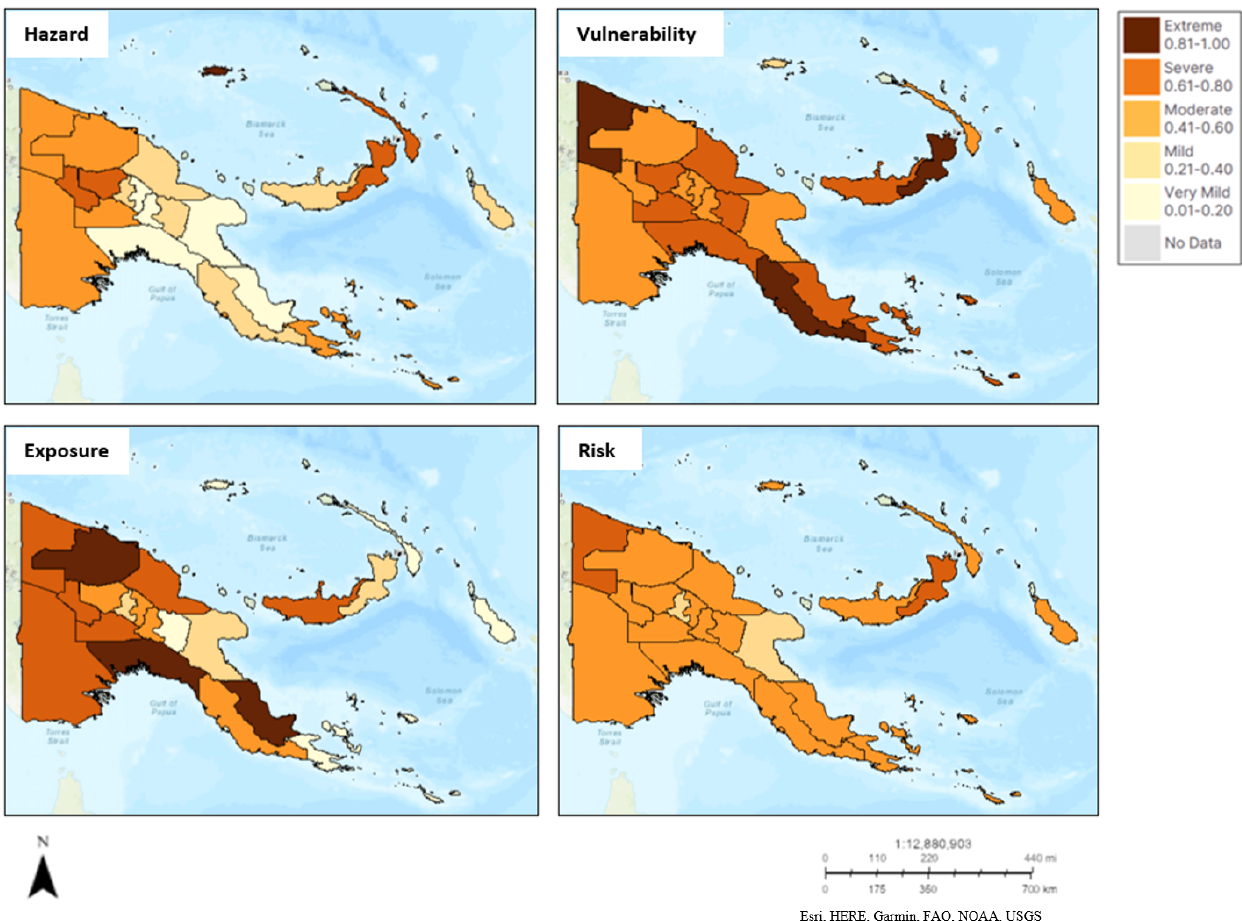
Figure 9. Overall drought risk maps of PNG provinces for 2020 including a drought hazard, drought vulnerability, drought exposure, and drought risk map detailing the index level of each province. The index level is classified on a deepening orange colour scale from mild (index values from 0.01–0.25) to extreme (index values from